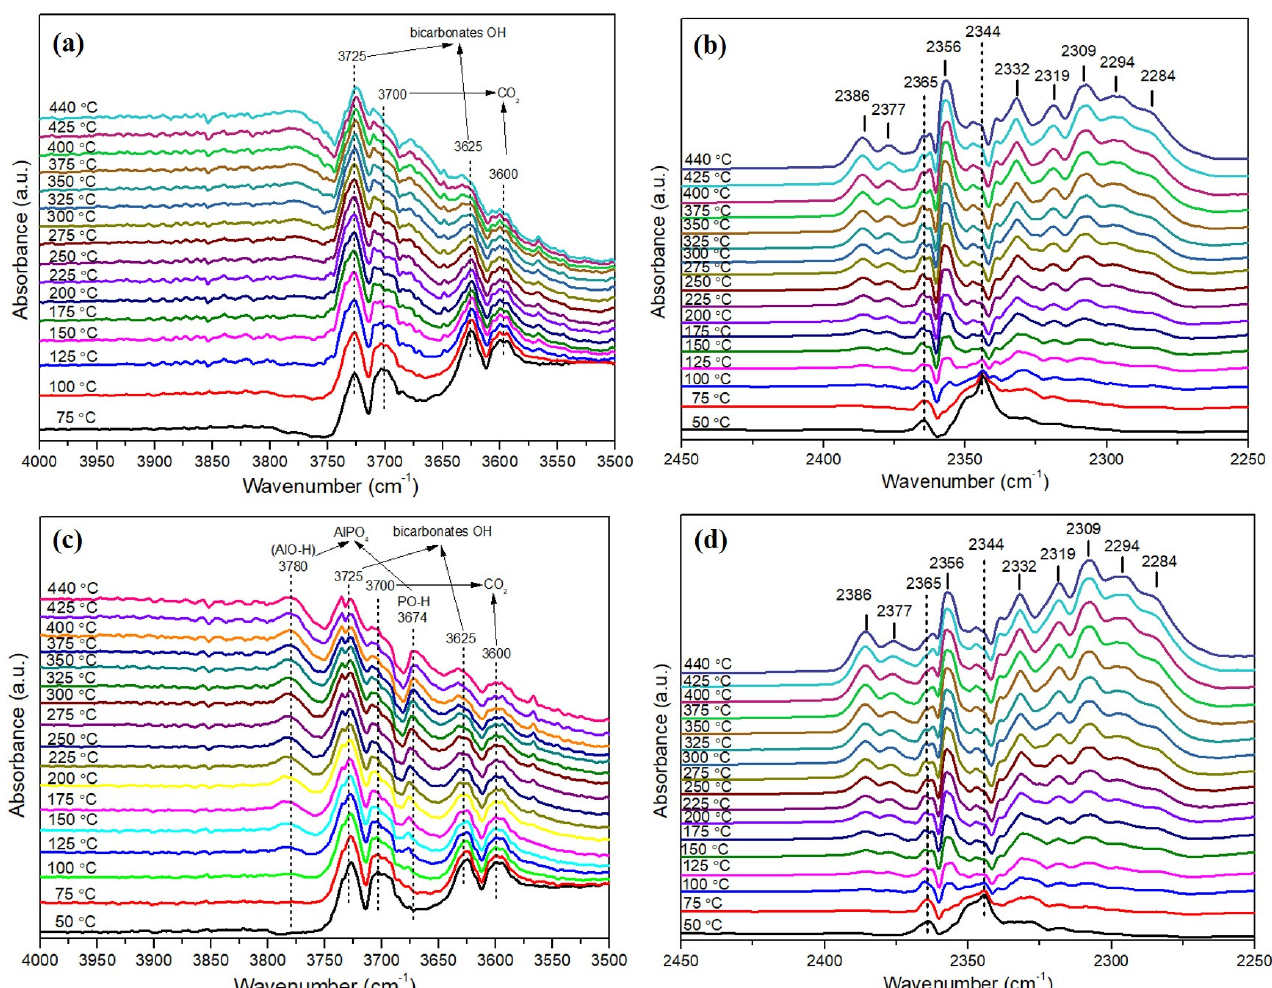
Figure 10. Partial DRIFT spectra of CO 2 adsorbed at different temperatures over Ni/Al 2 O 3 with the wavelength 3500–4000 cm − 1 ( a ), 2250–2450 cm − 1 ( b ), and over NiP-2/Al 2 O 3 catalyst with the wavelength 3500–4000 cm − 1 ( c ), 2250–2450 cm − 1 ( d ).